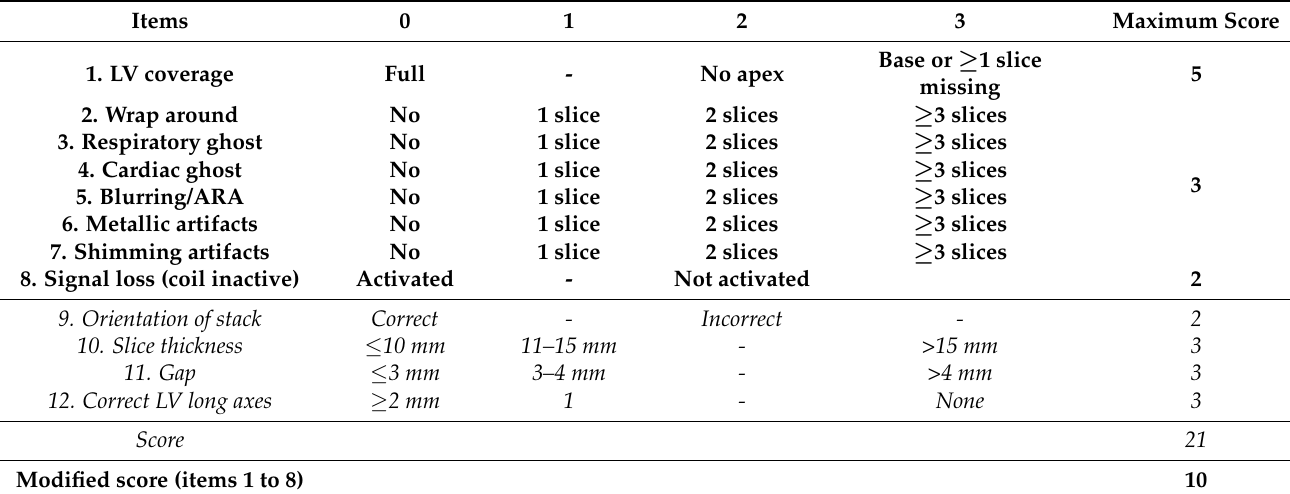
Table 2. “LV-Function cine SSFP” section of the standardized objective quality criteria score based on the European CMR registry. Adapted from [22] (p.